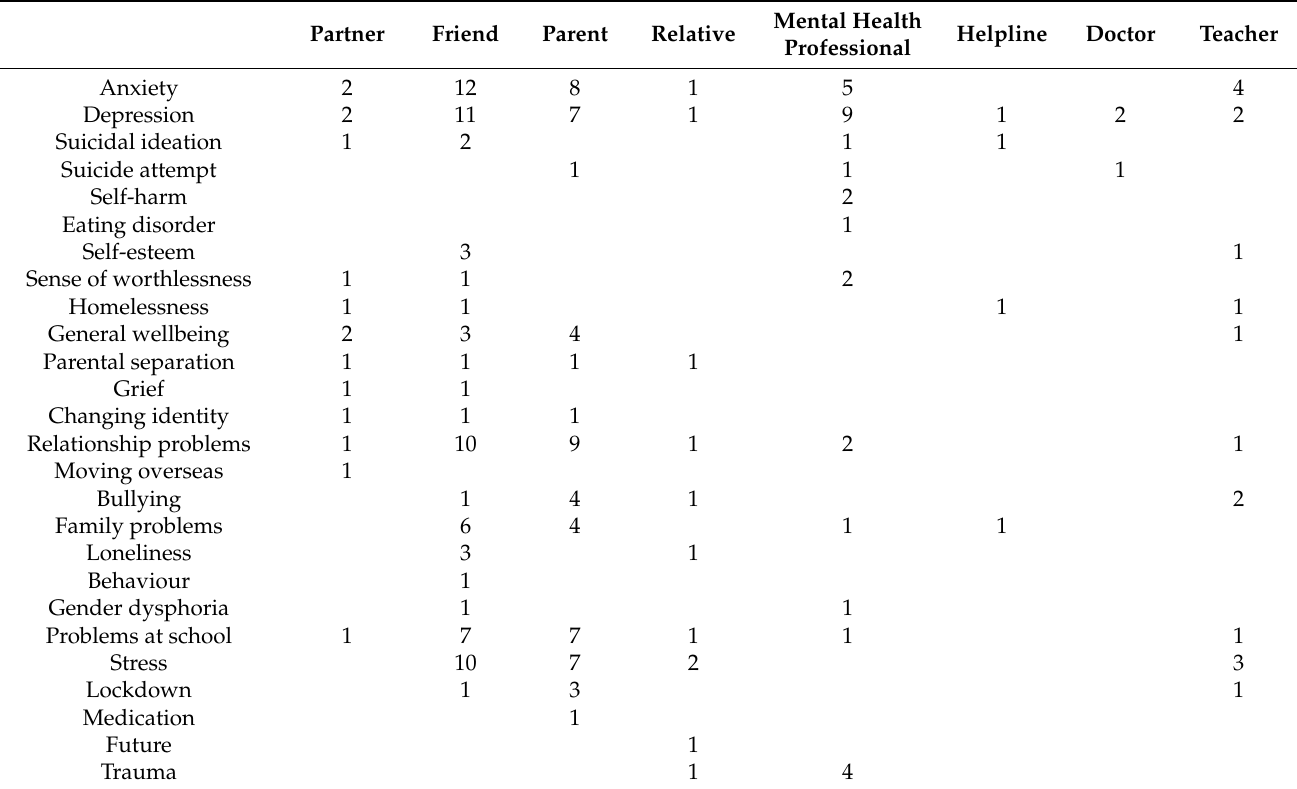
Table 2. Reported problems participants had sought help for in the past two